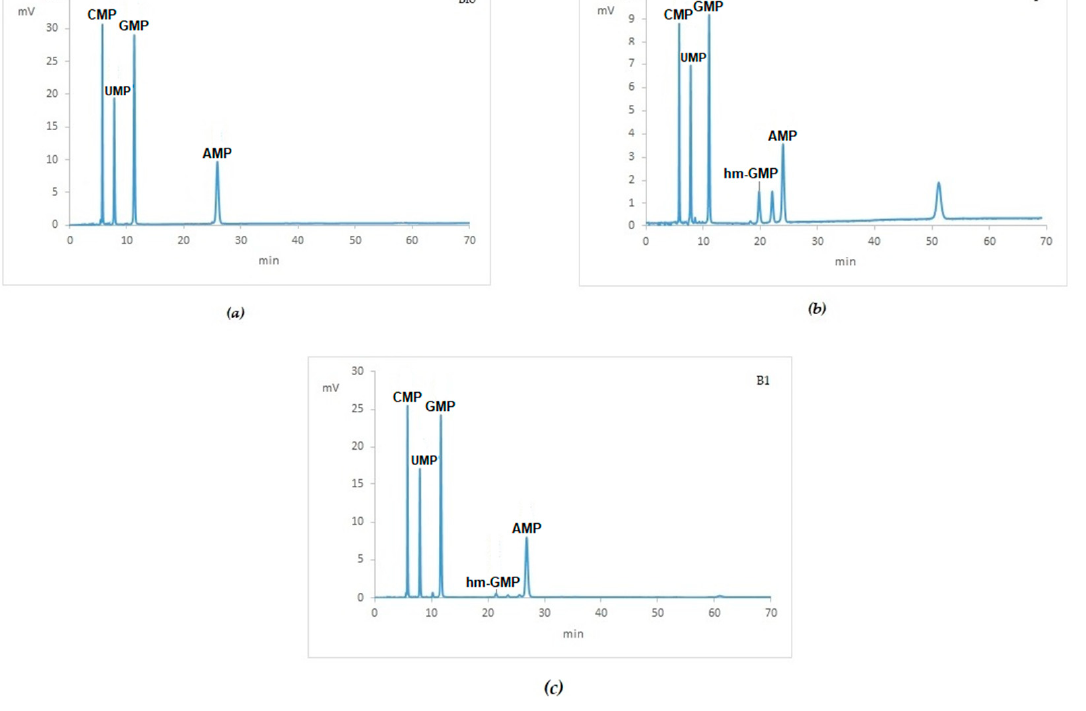
Figure 7. HPLC analysis of routine clinical samples: Chromatograms of ( a ) RNA from peripheral blood; ( b ) FFPE (ovarian cancer); ( c ) BFPE (ovarian cancer). Fixed and paraffin-embedded ovarian cancers display more complex patterns of digestion. Table 7. Results of HPLC analysis as area percentage of canonical NMPs and integrity of clinical samples. Samples’ age is reported in years.